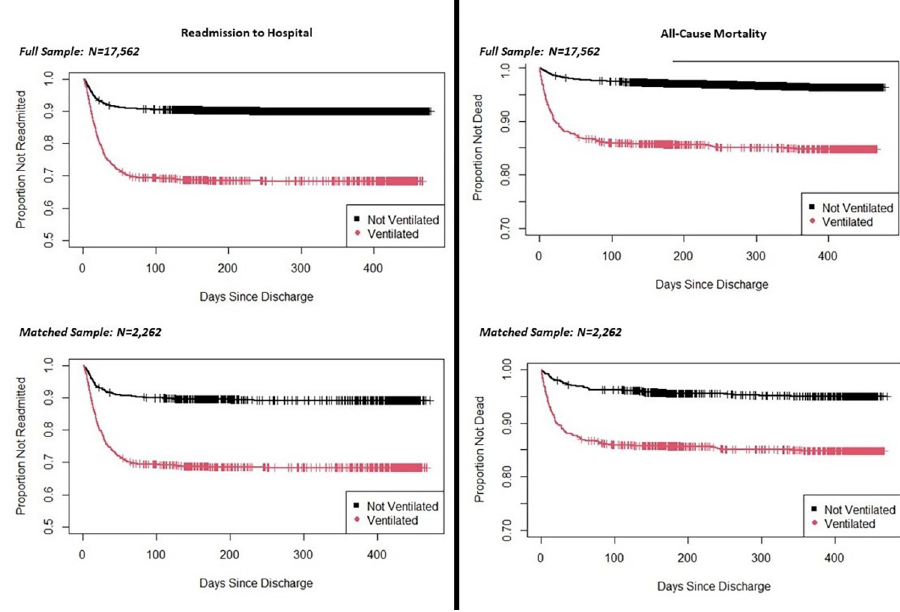
Fig 1. Kaplan-Meier curve for readmission to hospital and all-cause mortality by treatment group.